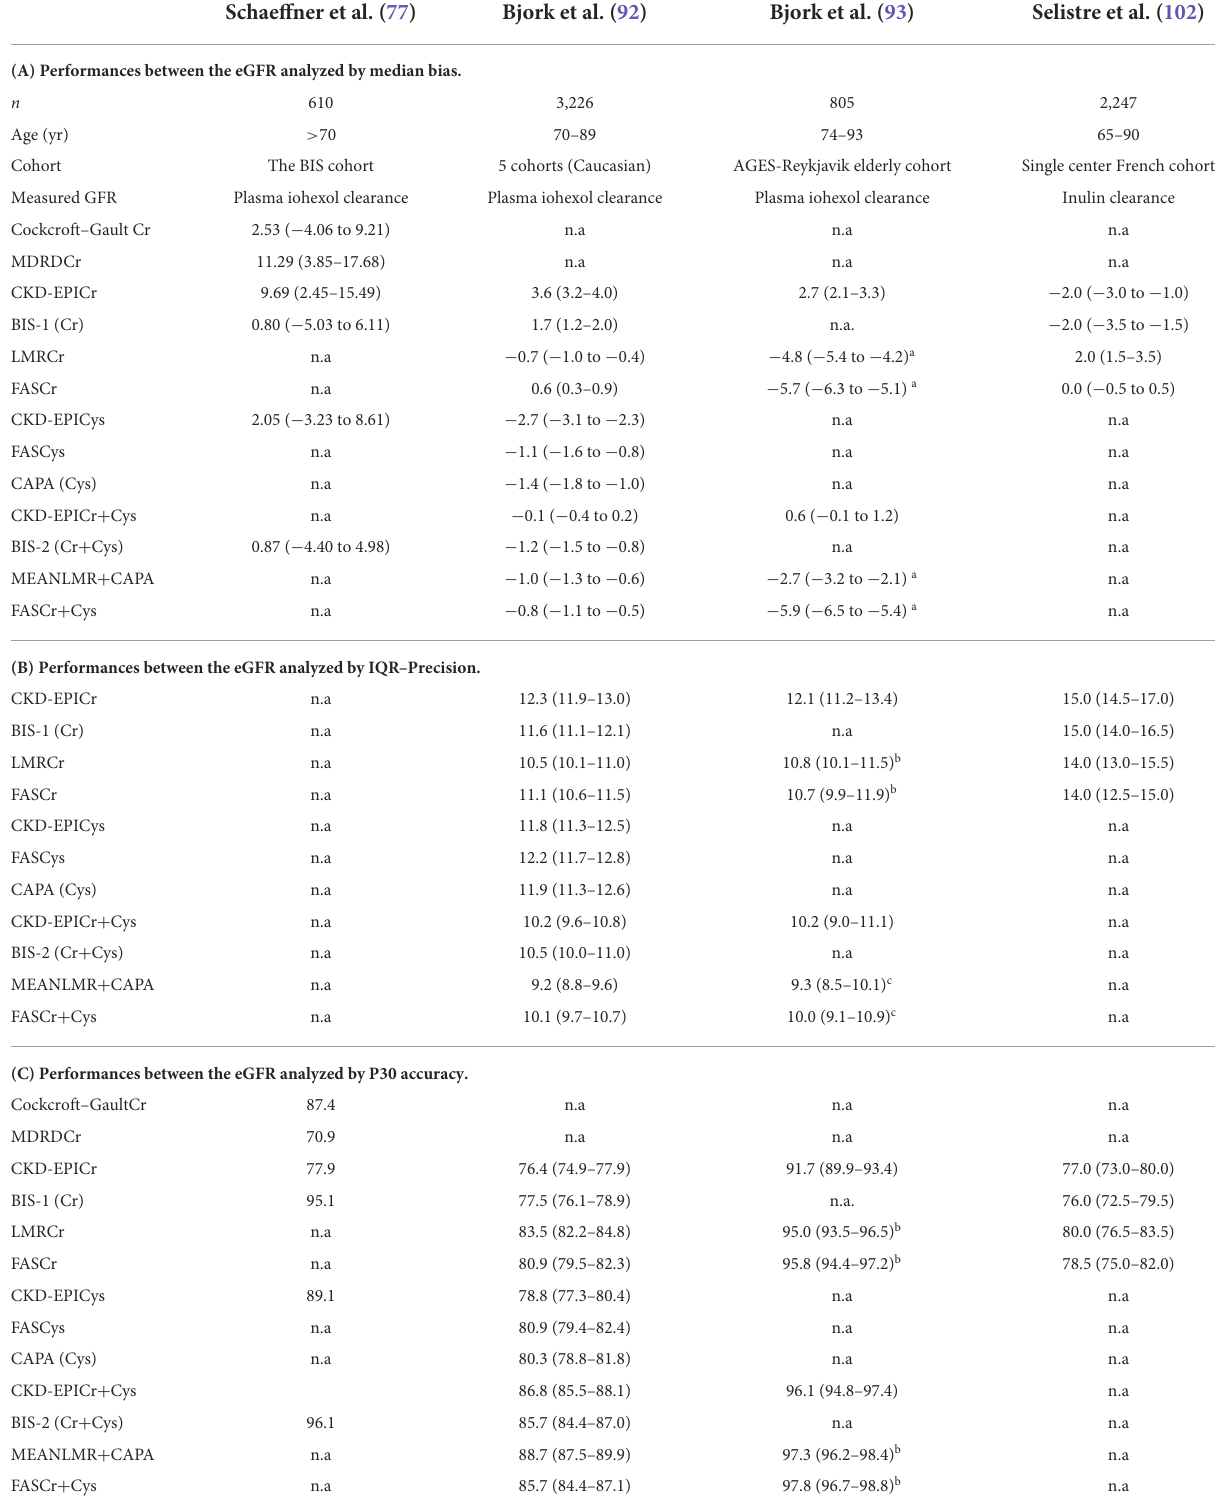
TABLE 4 Studies comparing discrepancies of GFR estimating equations and estimated creatinine clearance (Cockcroft–Gault) in older adults examining performances between the eGFR analyzed by metrics such as bias, precision, and